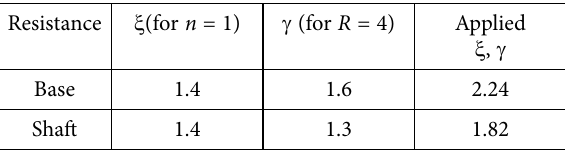
Table 5. Safety factors applied in Eq. 4